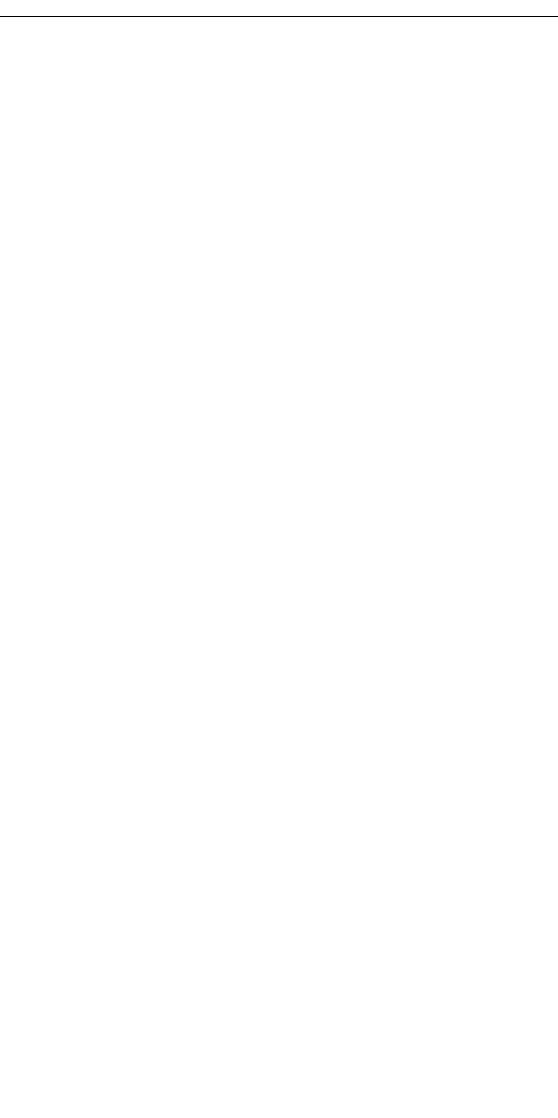
FIGUREA3 | Suppression assays performed using ex vivo T regs from healthy donors . PBMCs from healthy donors were stained withT reg markers, CD4, CD25, andTNFR2 to sort for non-induced ex vivo T regs .T regs were identified as either CD4 + CD25 hi TNFR2 + T cells or CD4 + CD25 hi TNFR2 − T cells.The sortedT regs were added to autologous responders (CD4 + T cells) at a ratio of 1:1 and stimulated with anti-CD3/28 for 72h in 96 well plates. (A) Represents a suppression assay using CD25 hi TNFR2 + T cells as theT reg population while (B) Represents a suppression assay using CD25 hi TNFR2 − T cells as theT reg population. Data shown here represents mean ± SD. Unpaired t -tests was used to determine statistical significance. * p <